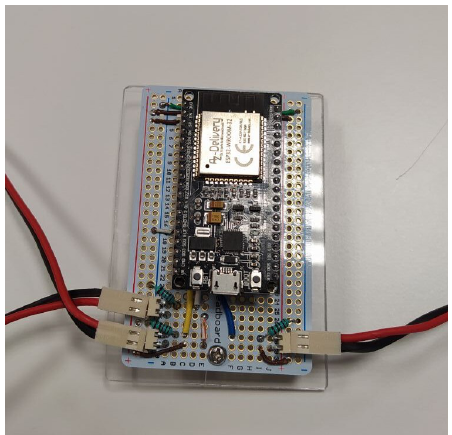
Figure 4. Processing node used for in-bed